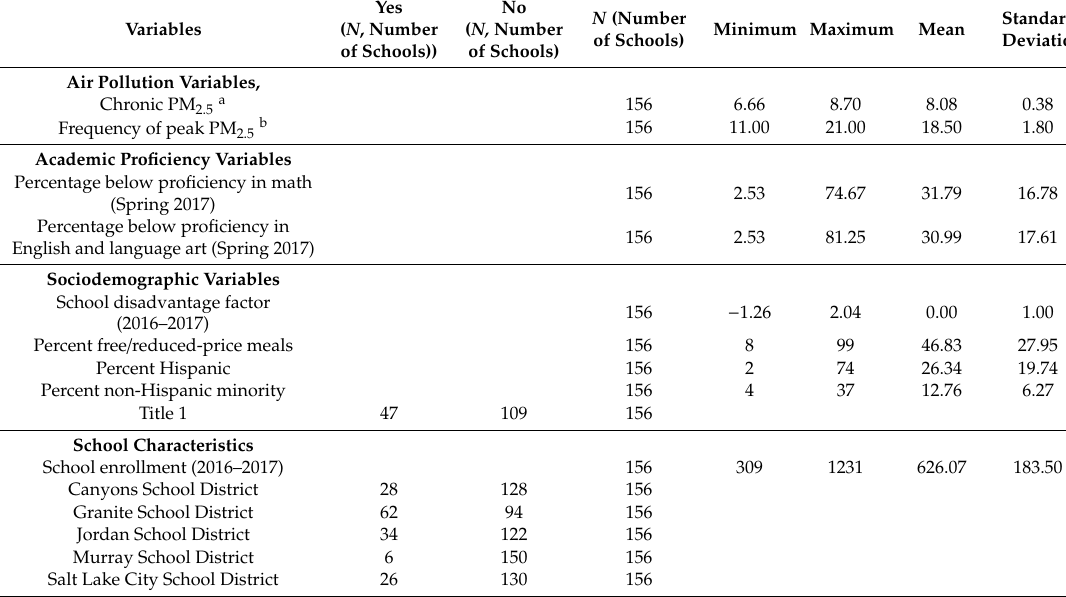
Table 1. Descriptive statistics of analysis variables ( n = 156